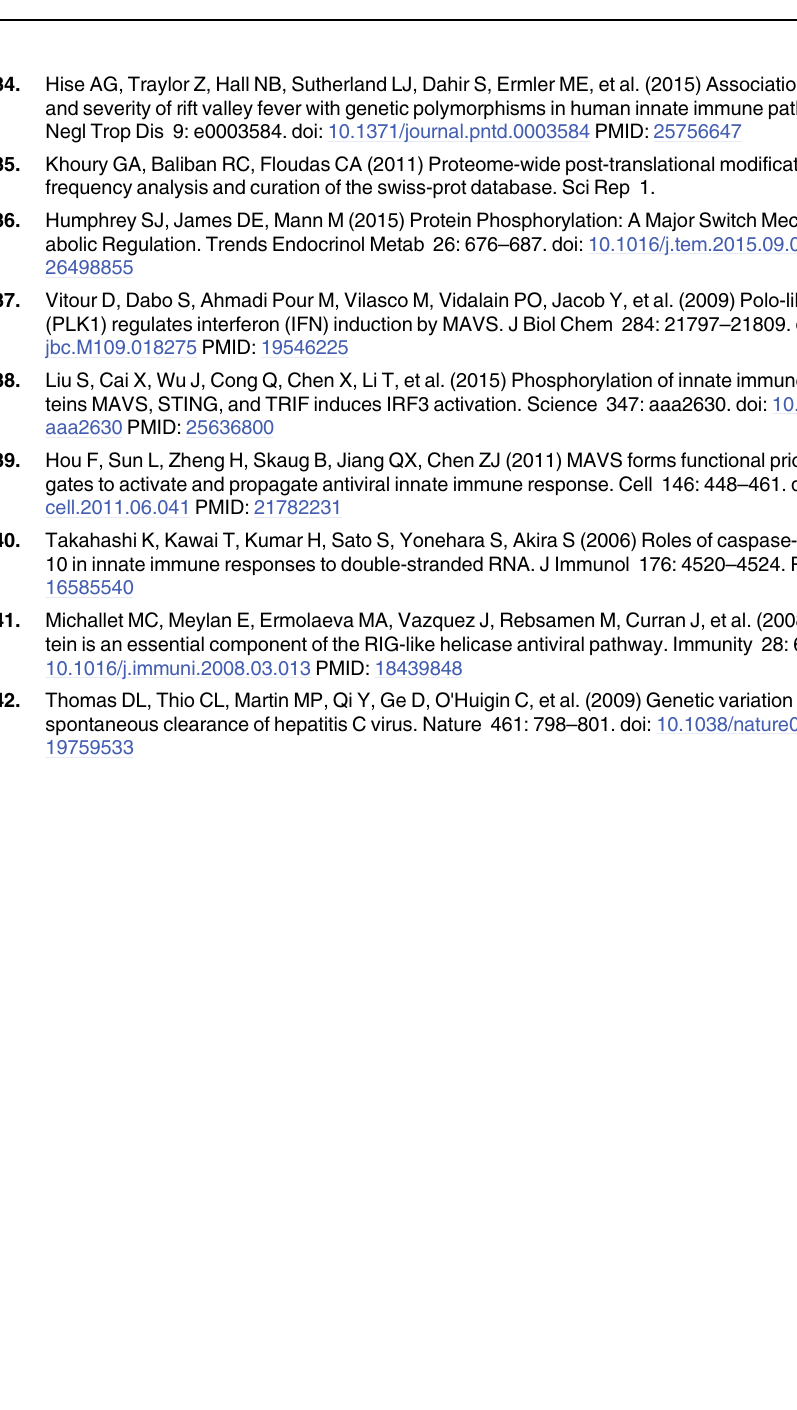
PLOS ONE | DOI:10.1371/journal.pone.0151173 March 8,